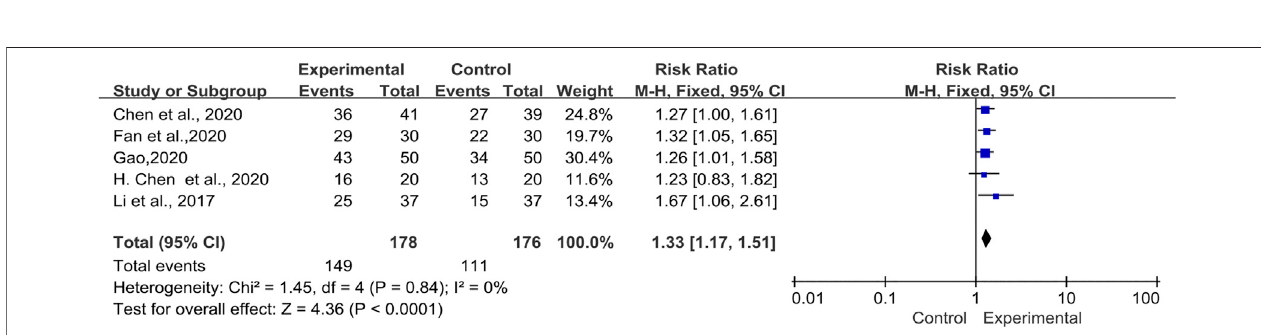
Frontiers in Pharmacology |